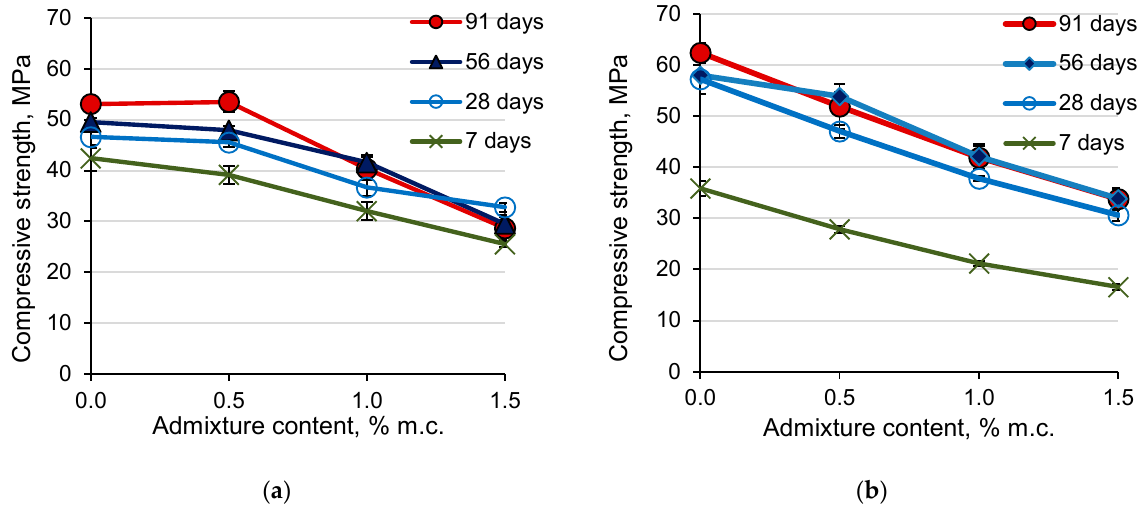
Figure 6. The effect of the admixture containing aluminum on the compressive strength of mortars with ( a ) CEM I cement, ( b ) CEM III cement.